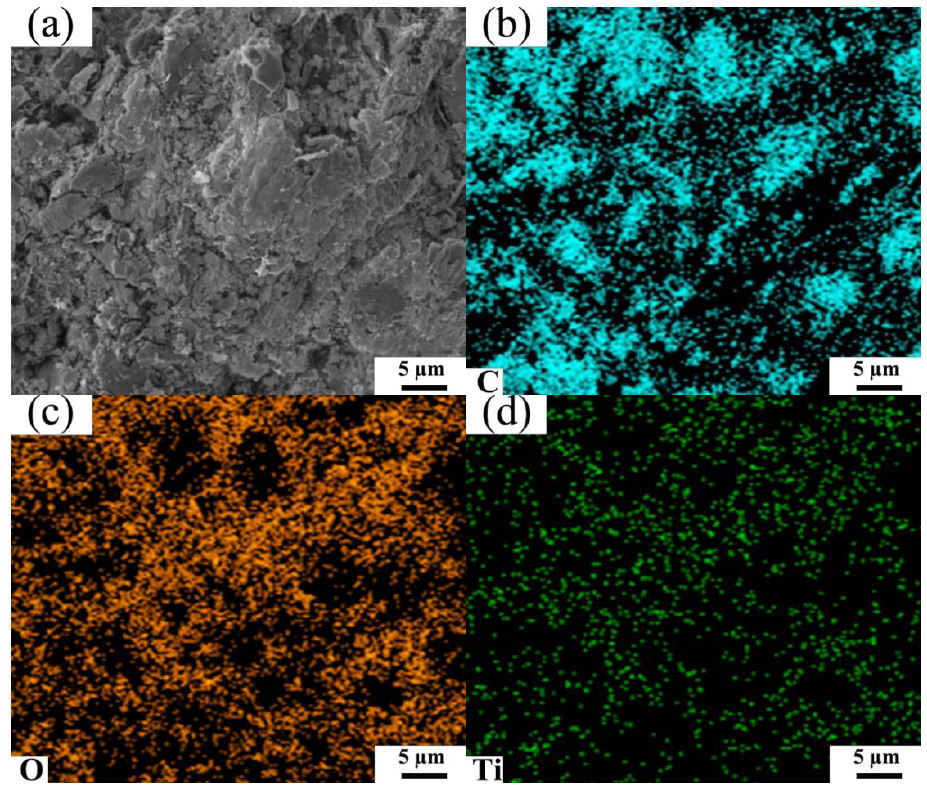
Figure 6. ( a ) SEM image and ( b ) C, ( c ) O, ( d ) Ti elemental mapping of graphite–cement mortar with TCS as an aggregate.